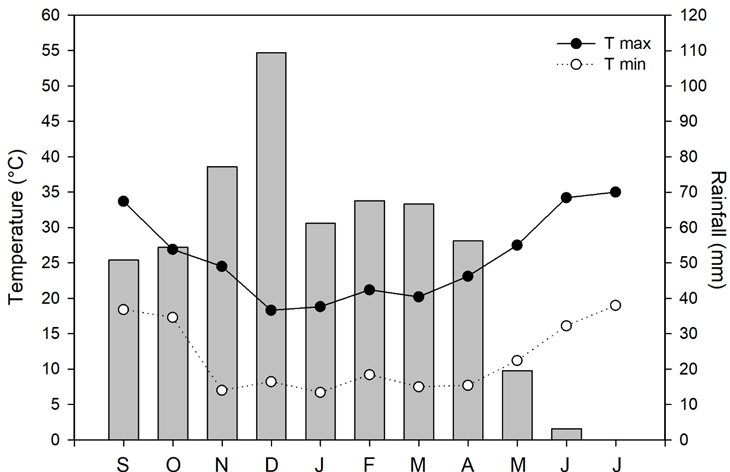
Figure 1. Meteorological trend (maximum and minimum air temperature and rainfall) during the growing season of 2013/2014 in Southern Italy (Calabria, 38°04′51”N, 15°40′49”E).